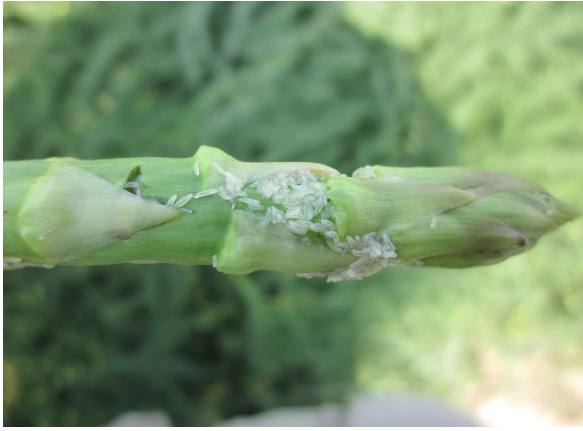
Figure 10. Number of emerging shoots infested and damaged by Prodiplosis per meter.